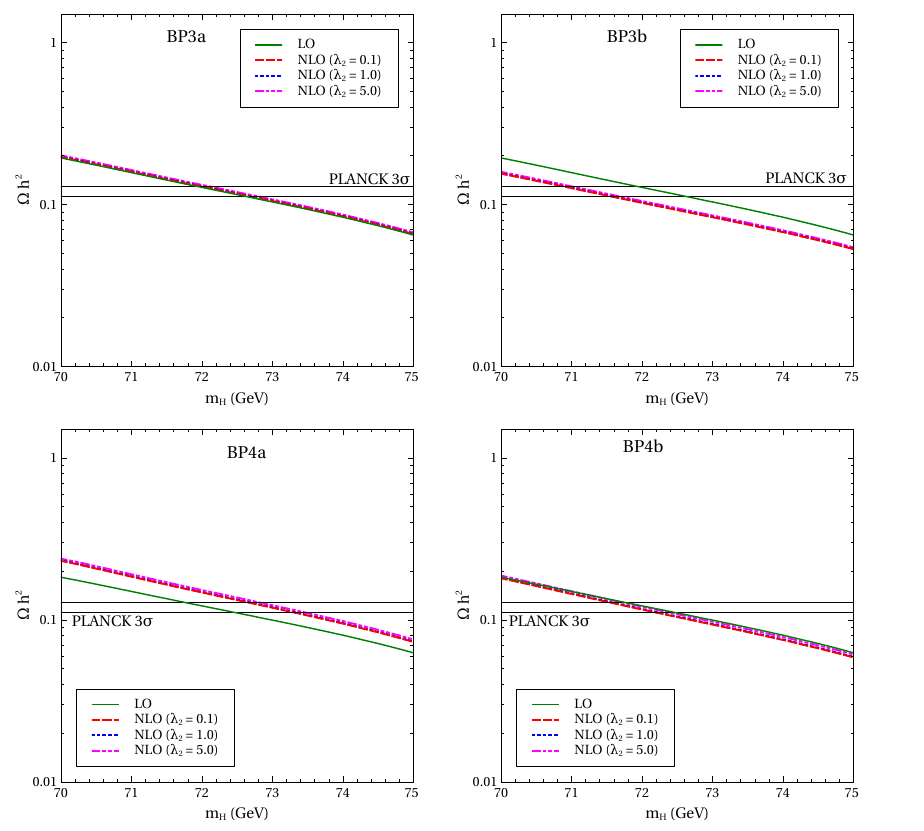
Figure 6 . The same as in (cid:12)gure 5 for BP3a, BP3b, BP4a and